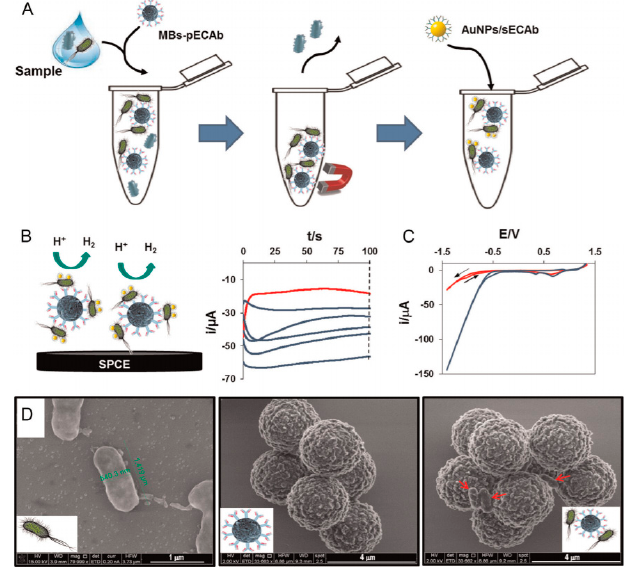
Figure 30. Schematic experimental design. ( A ) E. coli was captured by MBs modified with primary antibodies, and subsequently labelled with AuNPs carrying secondary antibodies; ( B ) Left: detection of labeled E. coli through the hydrogen evolution reaction electrocatalyzed by the AuNP labels. Right: Chronoamperograms registered in 1 M HCl, during the HER applying a constant voltage of 1.0 V for increasing E. coli concentrations (from top to bottom: 0, 102, 5 102, 103, 104 and 105 CFU mL − 1 ); ( C ) Cyclic voltammograms in 1 M HCl for 0 (red curve) and 10 5 (blue curve) CFU mL − 1 ; scan rate: 50 mV/s. ( D ) SEM image for heat-killed E. coli (left) and antibody modified MBs before (center) and after (right) incubation with 10 5 CFU mL − 1 of E. coli (bacteria are pointed by red arrows). Reprinted from [156], Copyright 2015, with permission from Elsevier.